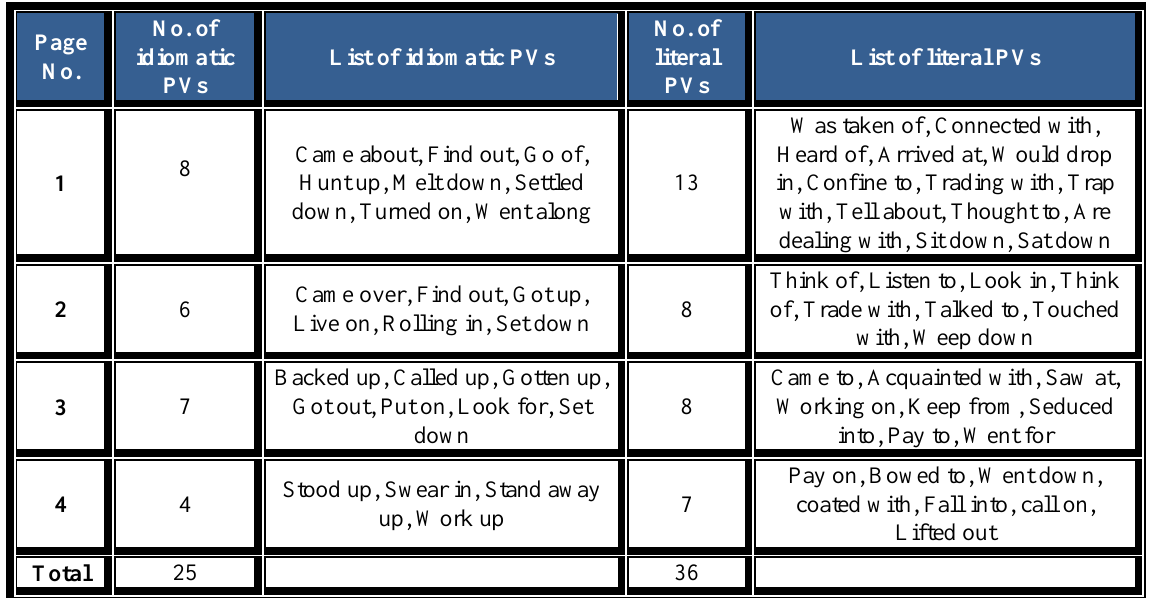
Table 4 – Number of idiomatic and literal PVs in MV